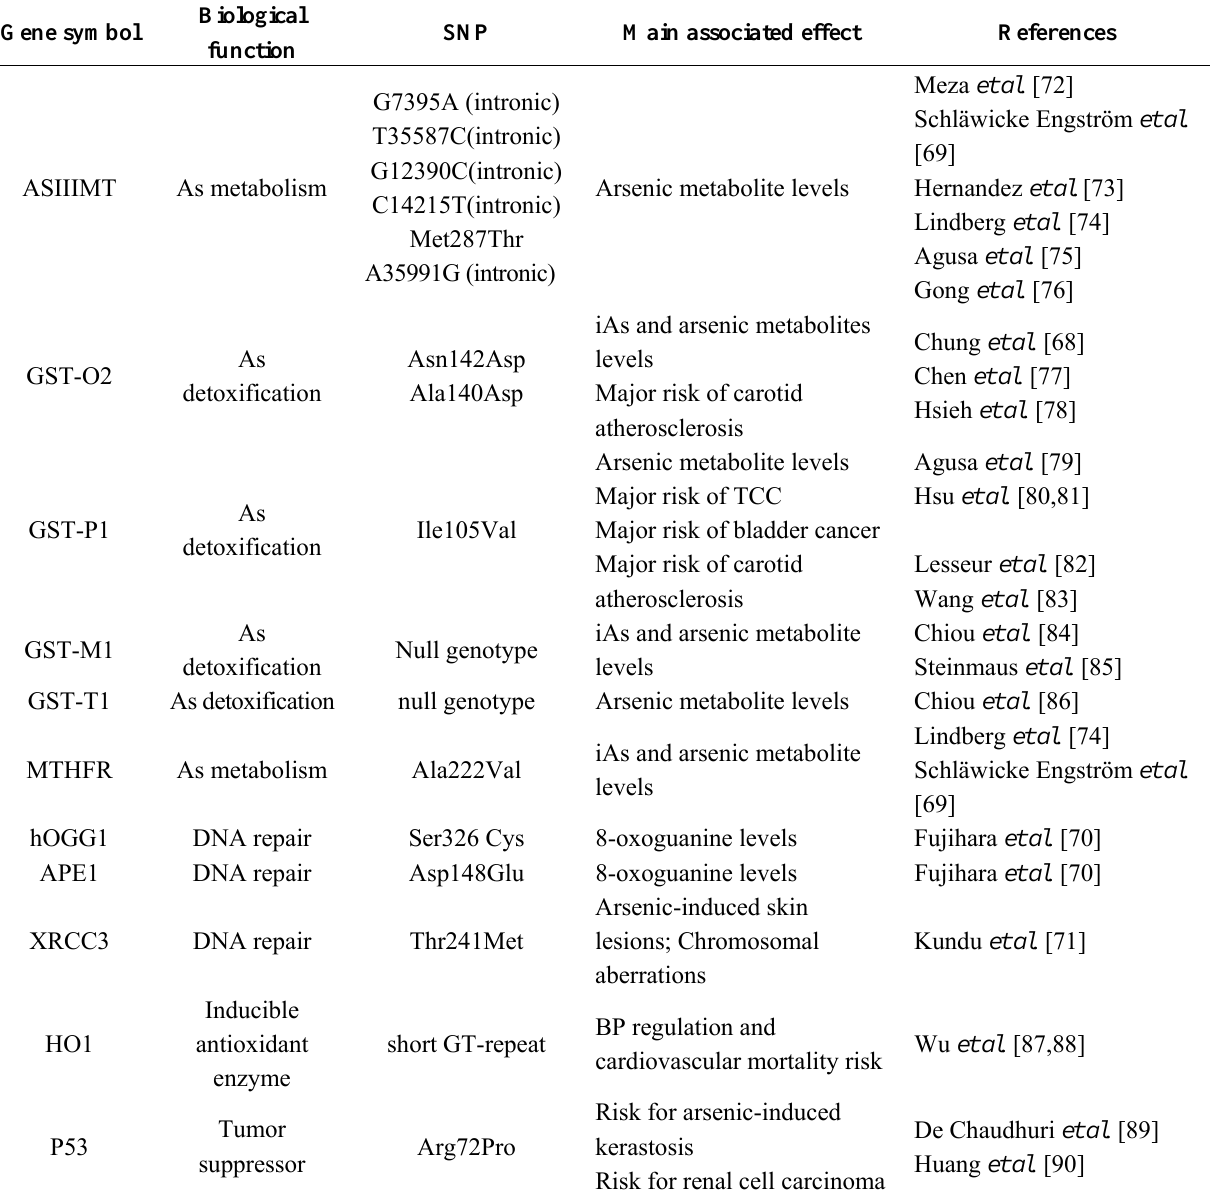
Table 2. Genetic polymorphisms involved in the susceptibility to arsenic